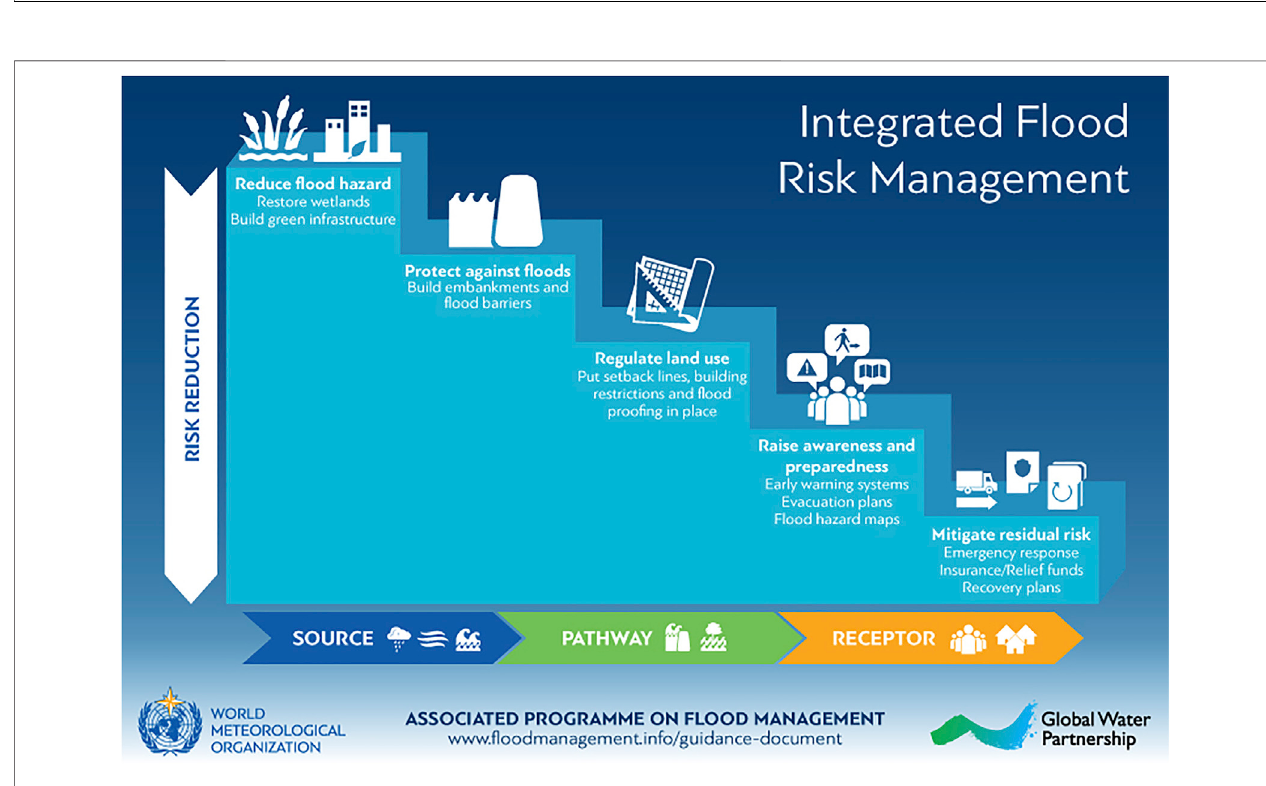
FIGURE 3 | Integrated fl ood risk management (WMO, 2017). Credit: World meteorological organization.